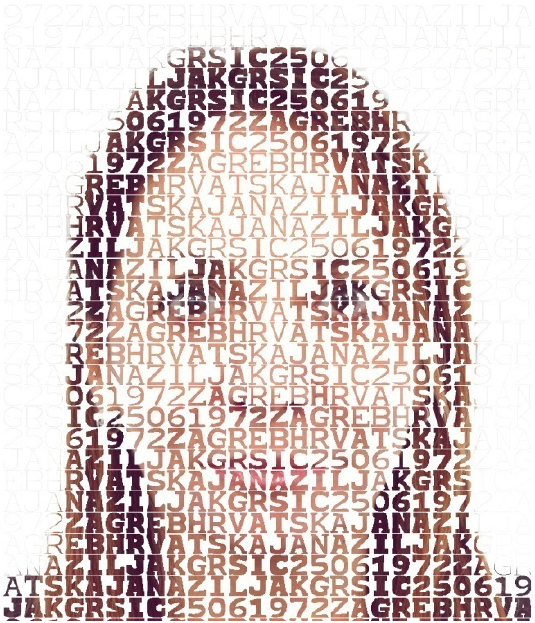
Figure 6. Portrait with a letter raster.